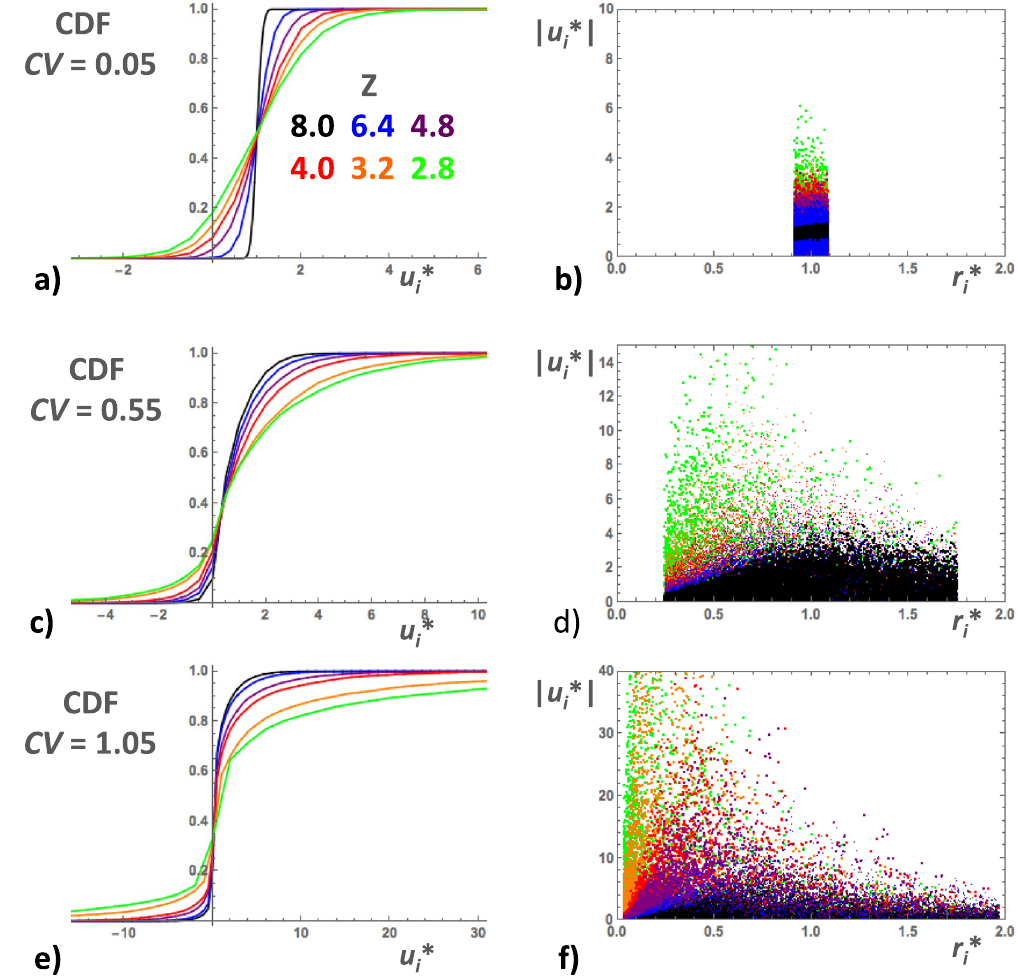
Figure 5. Examples of the cumulative distribution function (CDF) of u i * in BCC simulations with CV = 0.05 ( a ), 0.55 ( c ) and 1.05 ( e ). In each diagram, the CDF’s corresponding to different coordination numbers ( Z = 8.0, 6.4, 4.8, 4.0, 3.2 and 2.8) are represented by colored lines as indicated in the inset. Scatterplot of | u i * | versus r i * for the same simulations, CV = 0.05 ( b ), 0.55 ( d ) and 1.05 ( f) . Layers of colored data-points are superposed with the ones corresponding to Z = 8 on top and Z = 2.8 at the bottom. (See text for more